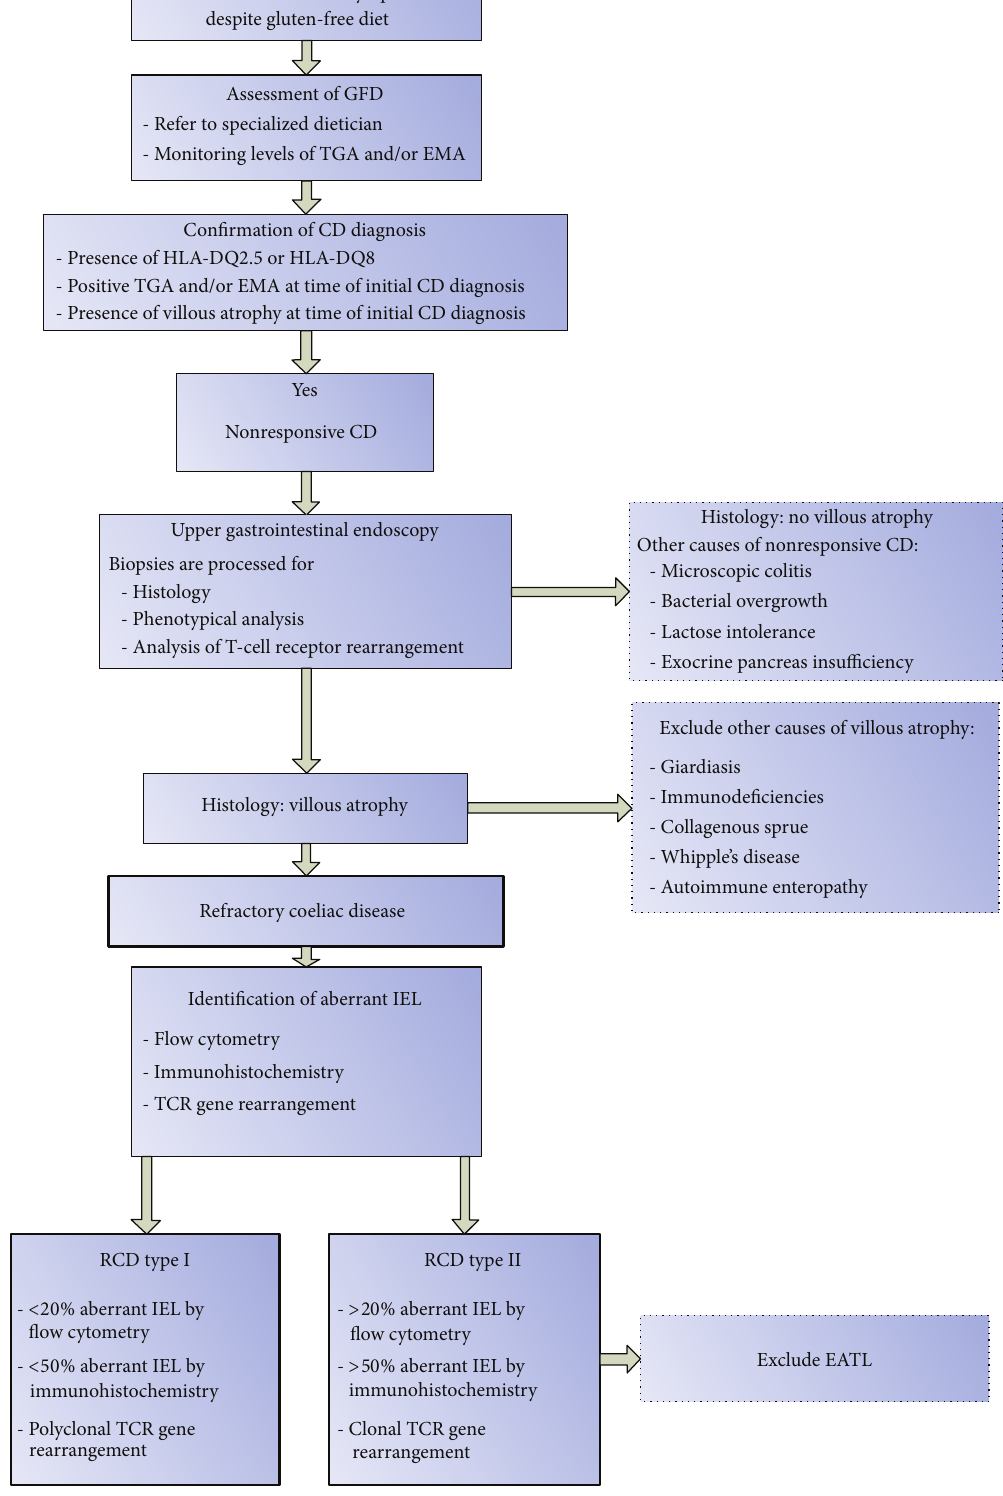
Figure 3: Algorithm for diagnostic approach of